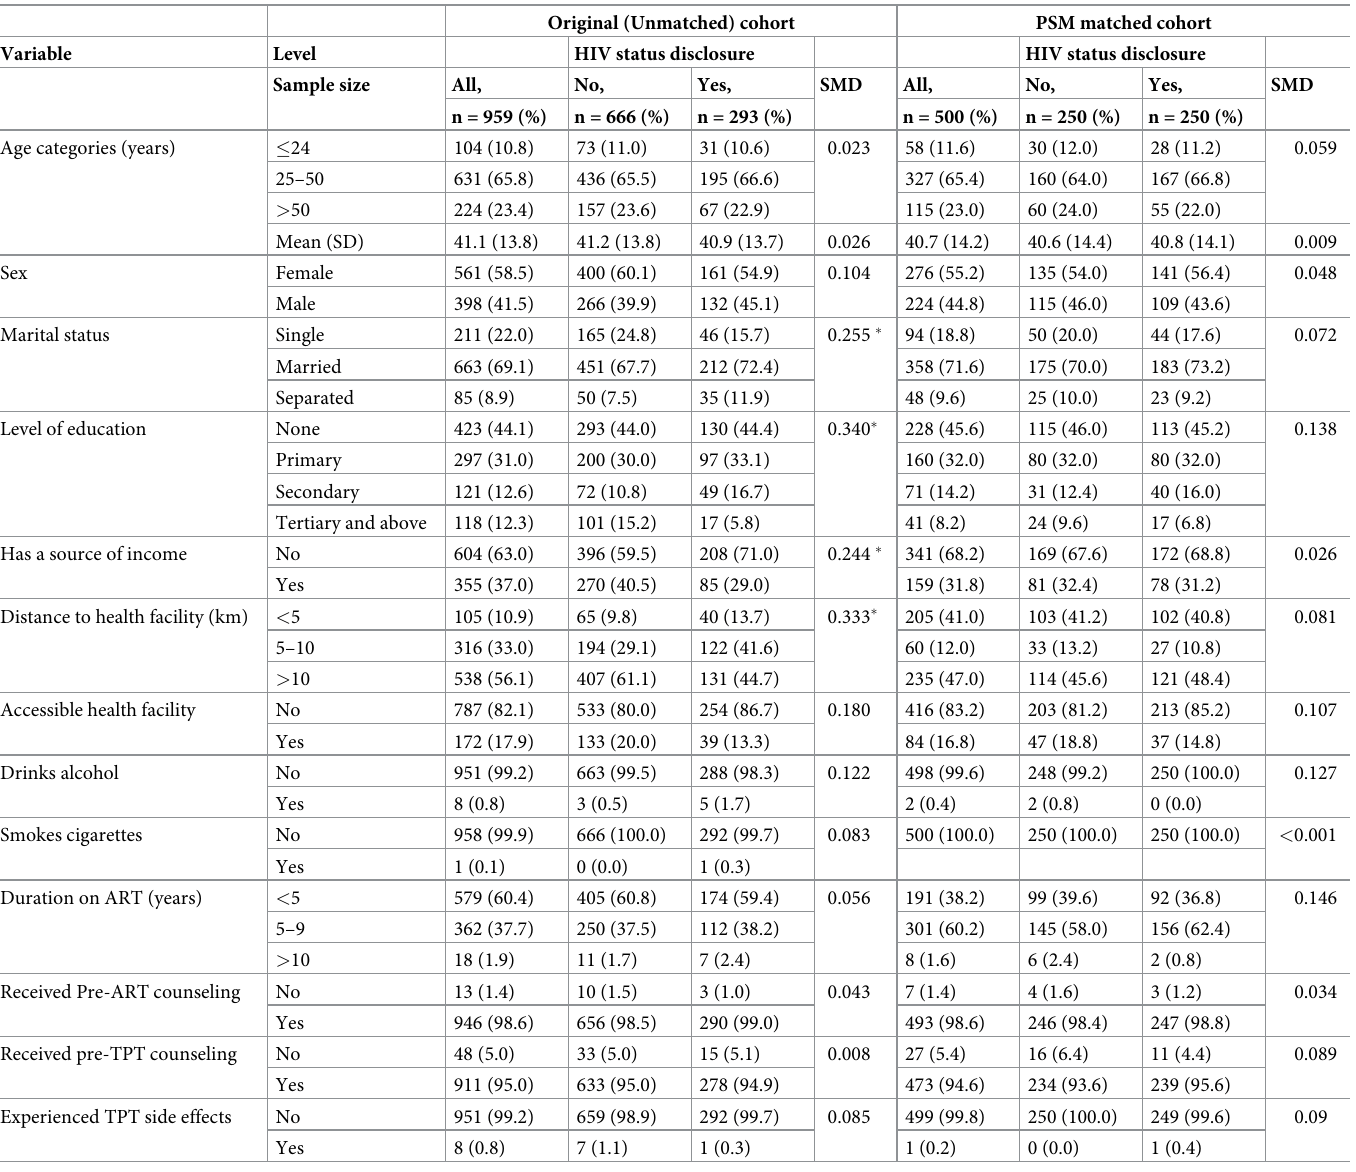
Table 1. Distribution of participants’ characteristics before and after propensity-score